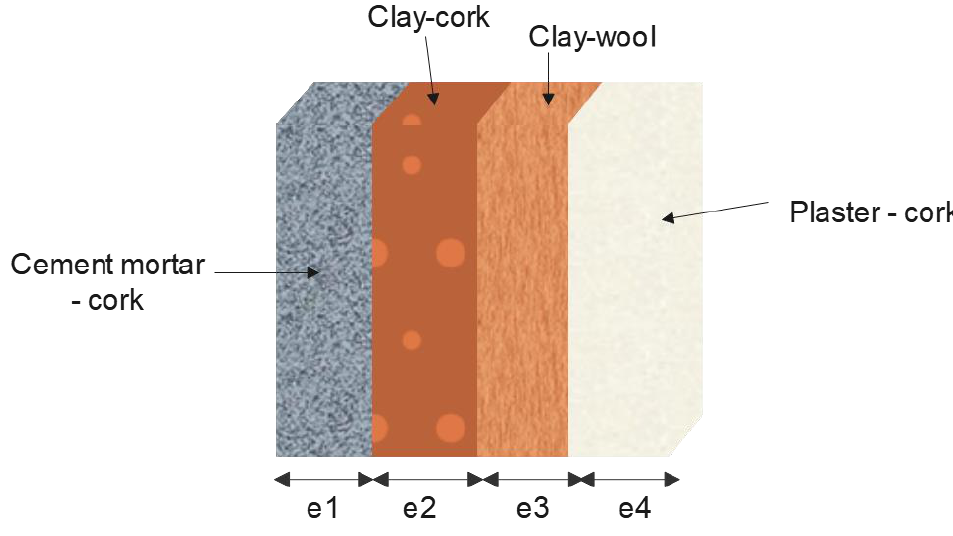
Figure 1. Representation of the studied multilayer material. For the intermediate layers, a number of scenarios were studied with varying layer thicknesses. The inner and outer layers stayed constant throughout the study.